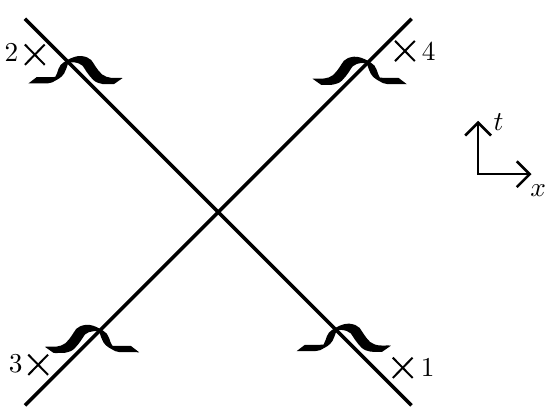
Figure 1 . Scattering of lumps. We probe this process by correlating four local